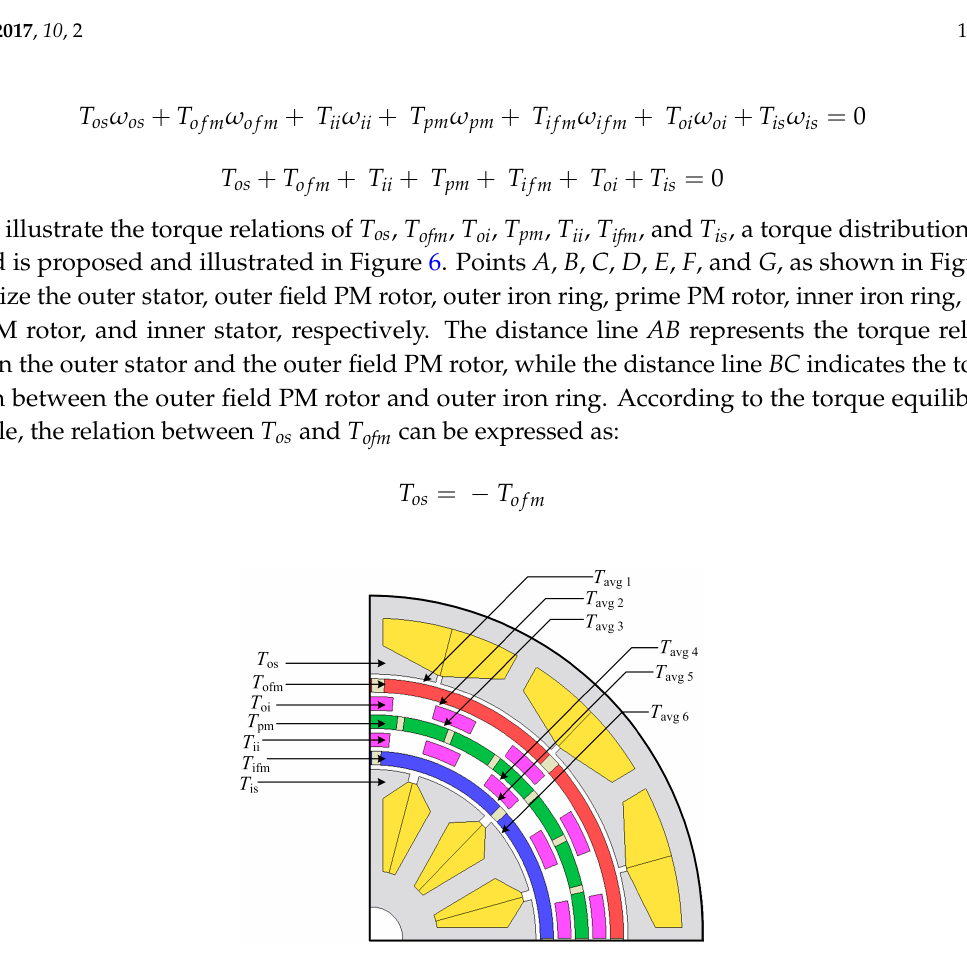
Figure 6. Torque distribution points of double-stator magnetic geared permanent magnet machine. Energies 2016 , 10 , 2